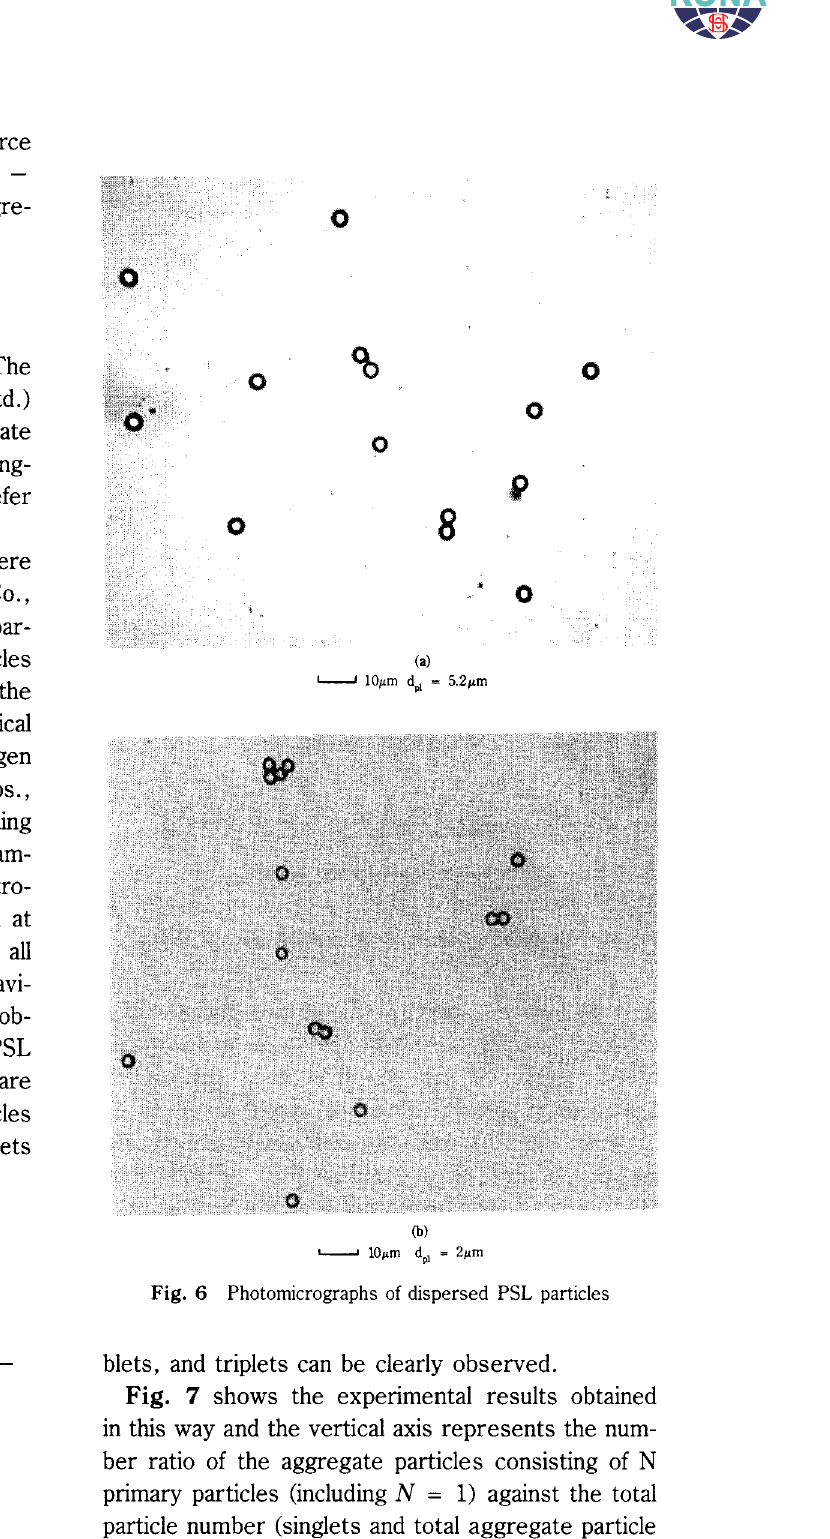
Fig. 6 Photomicrographs of dispersed PSL particles blets, and triplets can be clearly